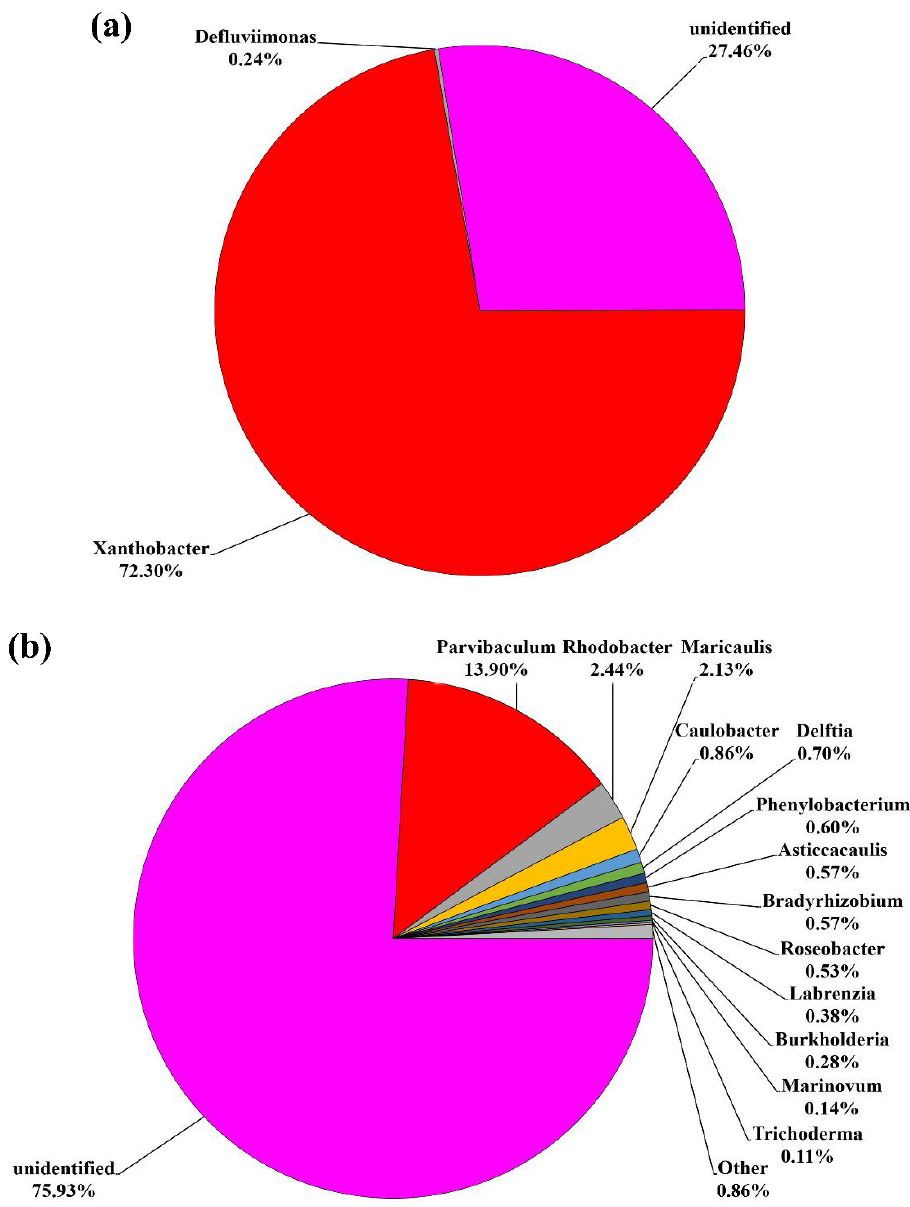
Figure 9. Species composition containing the As(III) oxidizing gene ( a ) aio A and ( b ) arx A in the genus-level (Other: the summation of the bacteria, of which the relative abundance was considerably below 0.1%).